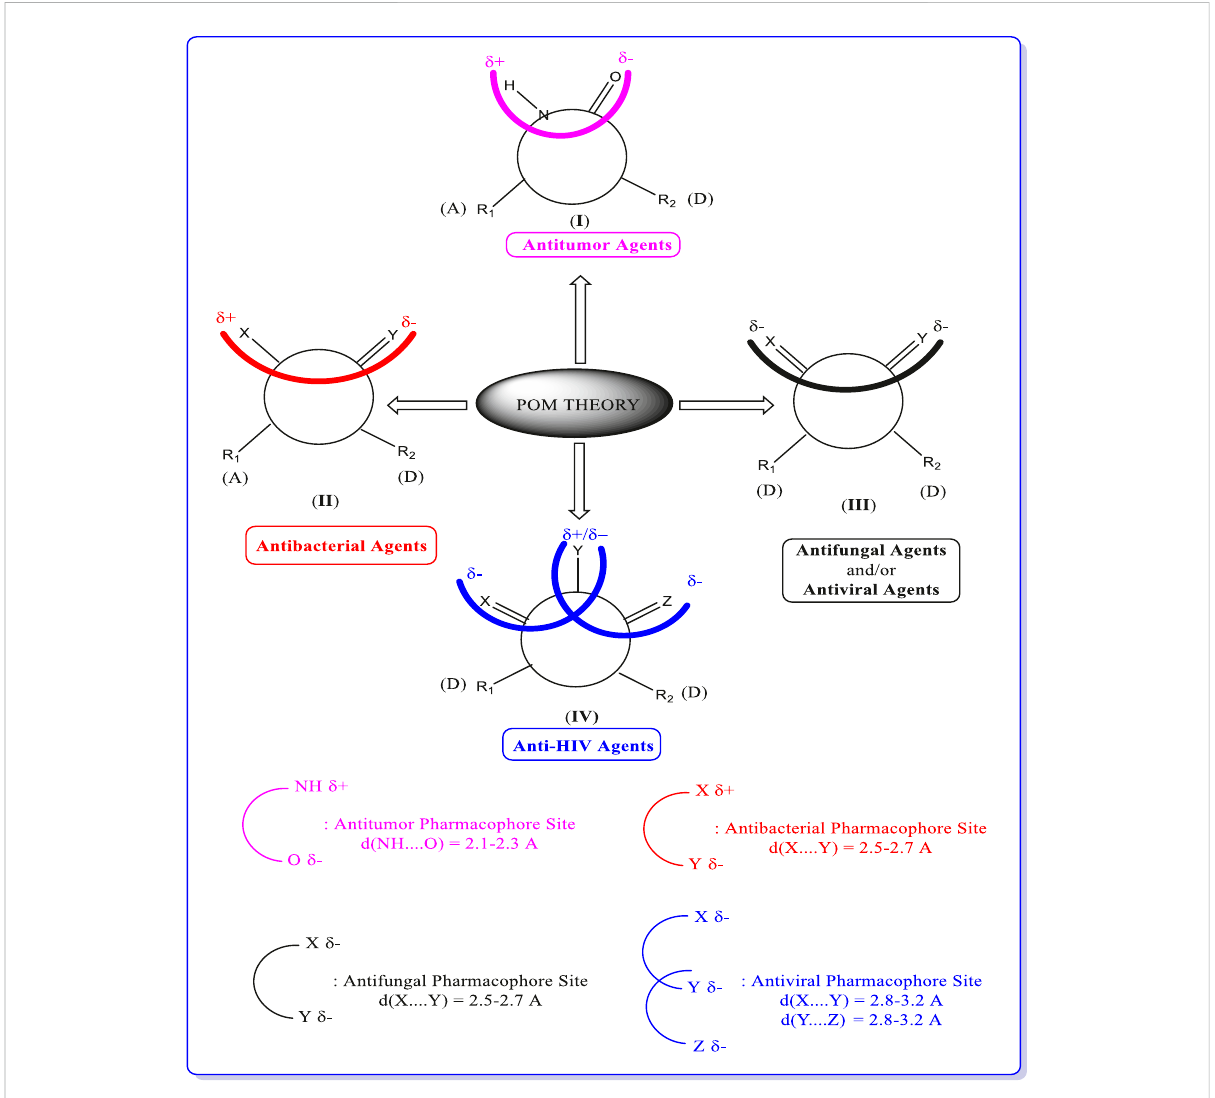
FIGURE 7 Concept and applications of POM theory in identifying and optimizing pharmacophore sites of various classes of drugs , developed by Prof. T. Ben Hadda (principal inventor of POM theory) in collaboration with NCI and TAACF of the United States (https://www.maroc.ma/fr/actualites/